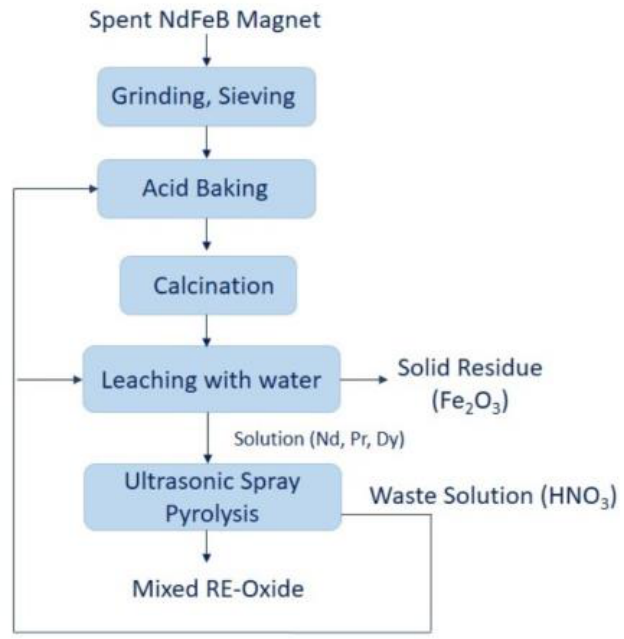
Figure 1. The proposed strategy for preparation of REE- oxides from spent NdFeB magnets.